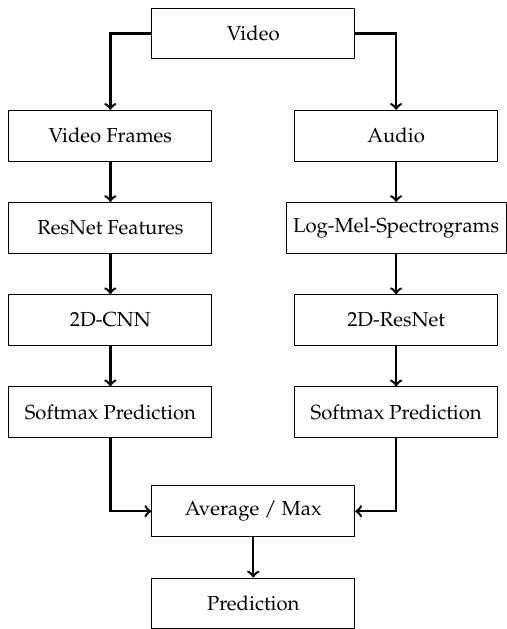
Figure 7. Late fusion. Visualization of how two seperate models can be fused through softmax average: a visual pathway that uses a feature extractor with a 2D-CNN, and an audio pathway that uses Log-Mel spectrograms with a 2D-ResNet. These models are trained individually, and the output predictions are fused by softmax (average or